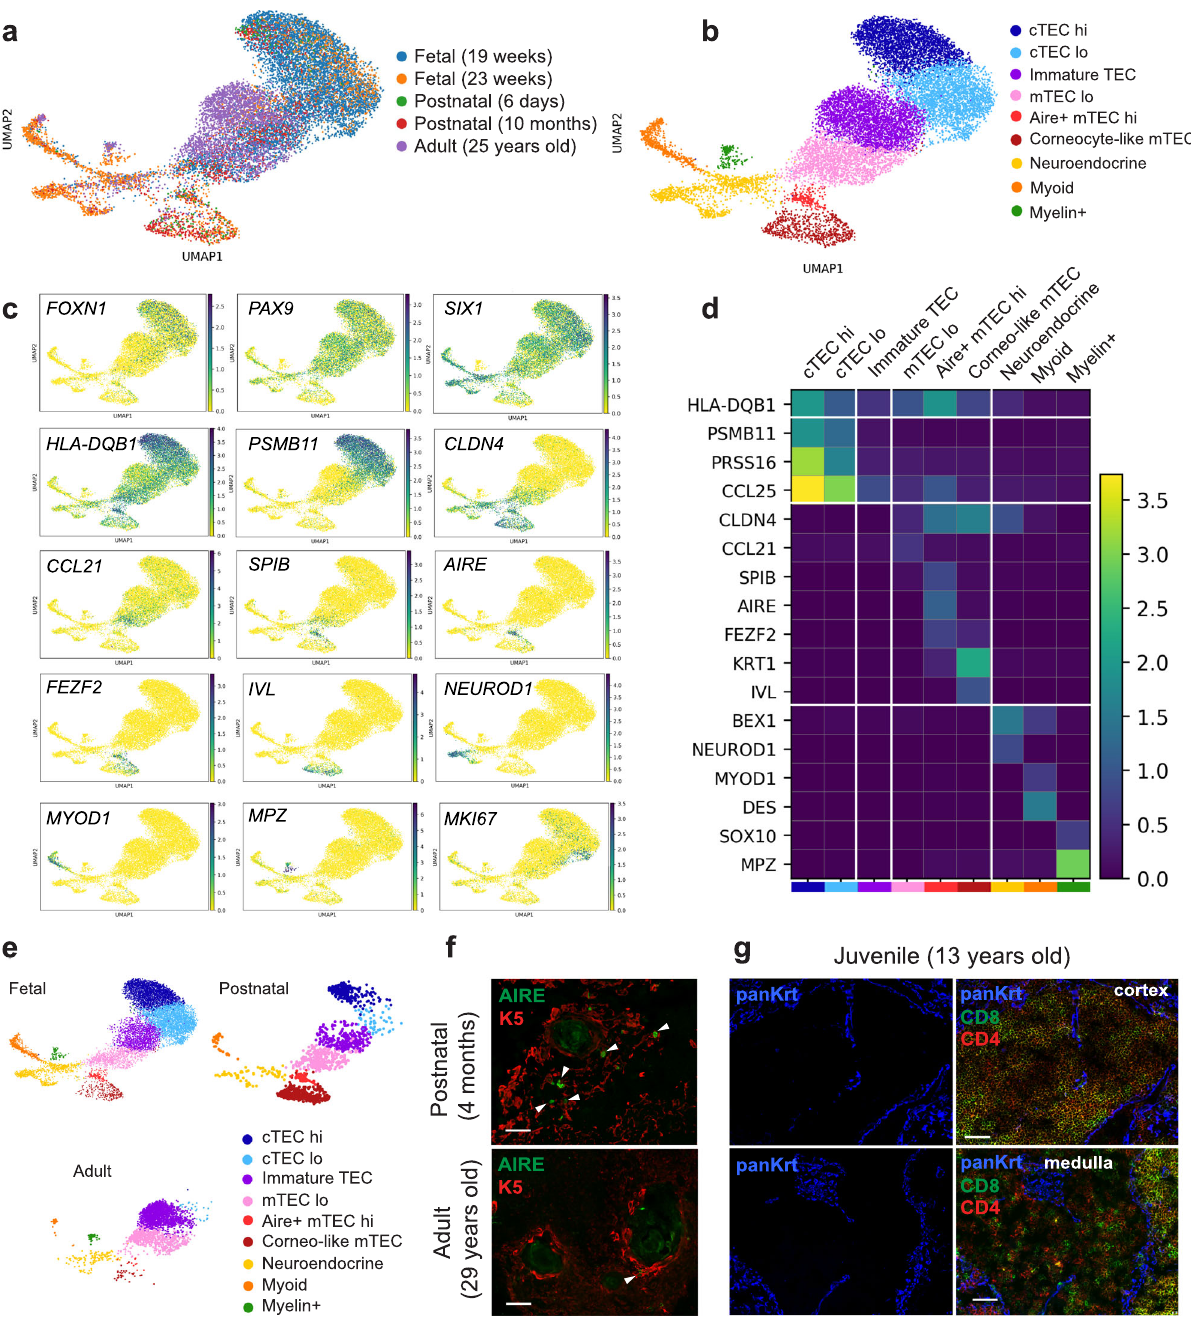
Fig. 2 Pro fi ling of human thymic epithelial cells at different stages. a UMAP visualization of epithelial cells colored by age group. b UMAP visualization of epithelial cells colored by cell types. c UMAP visualization of the expression of known marker genes used for cell cluster identi fi cation. d Heatmap showing the average expression of known marker genes in each epithelial cluster. e UMAP visualization of epithelial subsets in fetal, postnatal, and adult samples. f Immuno fl uorescence staining of AIRE + (green) K5 + (red) mTEC hi cells in postnatal and adult tissues. Arrowheads point to AIRE + cells. Scale bars, 50 μ m. g Thymic tissue from a 13-year-old donor was stained with CD8 (green) and CD4 (red) antibodies to visualize thymocytes together with a wide spectrum cytokeratin antibody to identify epithelial cells (blue). Scale bars, 50 μ m. Staining in f and g was repeated twice with many donors with similar